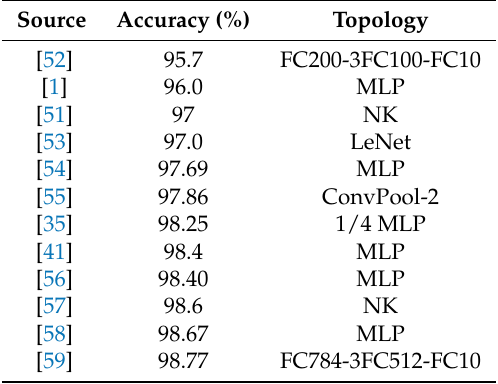
Table 5. BNN accuracies on the MNIST dataset. The accuracy reported for [51] was not explicitly stated by the authors. This number was inferred from the figure